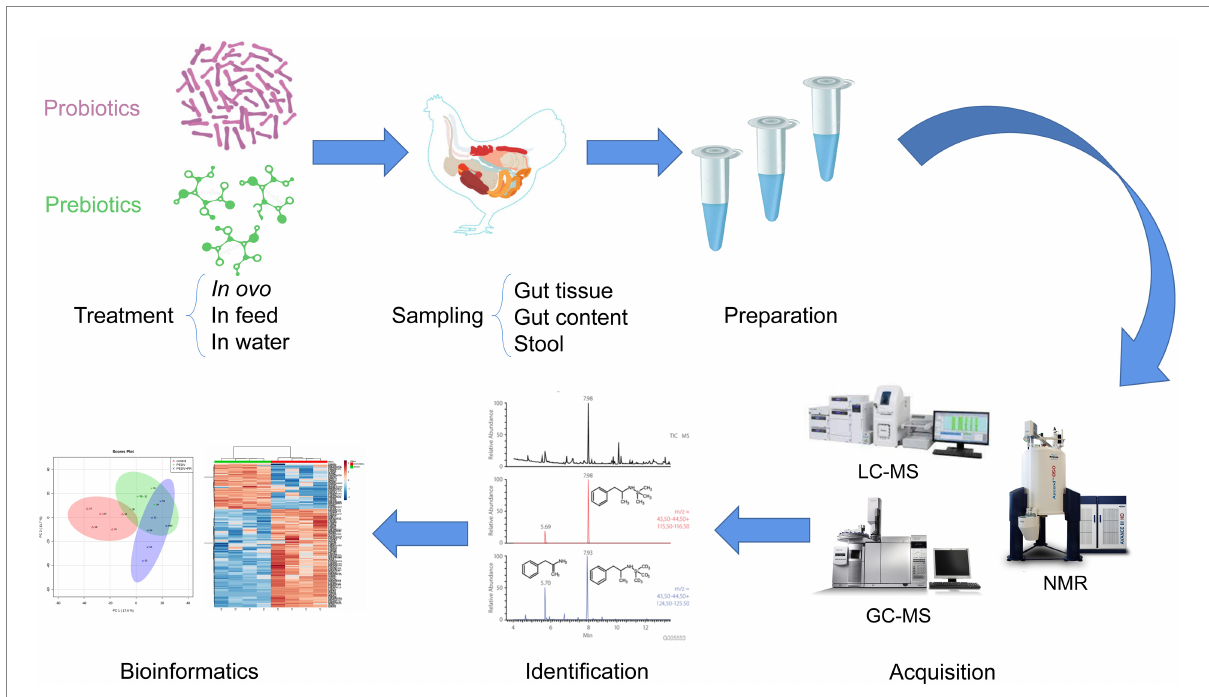
FIGURE 2 The general workflow of metabolomics analyses to study the effects of treatments with prebiotics and probiotics, in